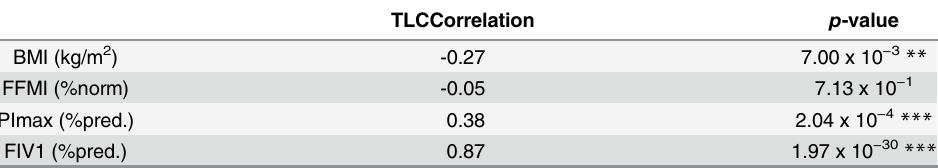
BMI, body mass index; FFMI, fat-free mass index; FIV1: forced inspiratory volume in 1 second; PImax: static inspiratory mouth pressure.